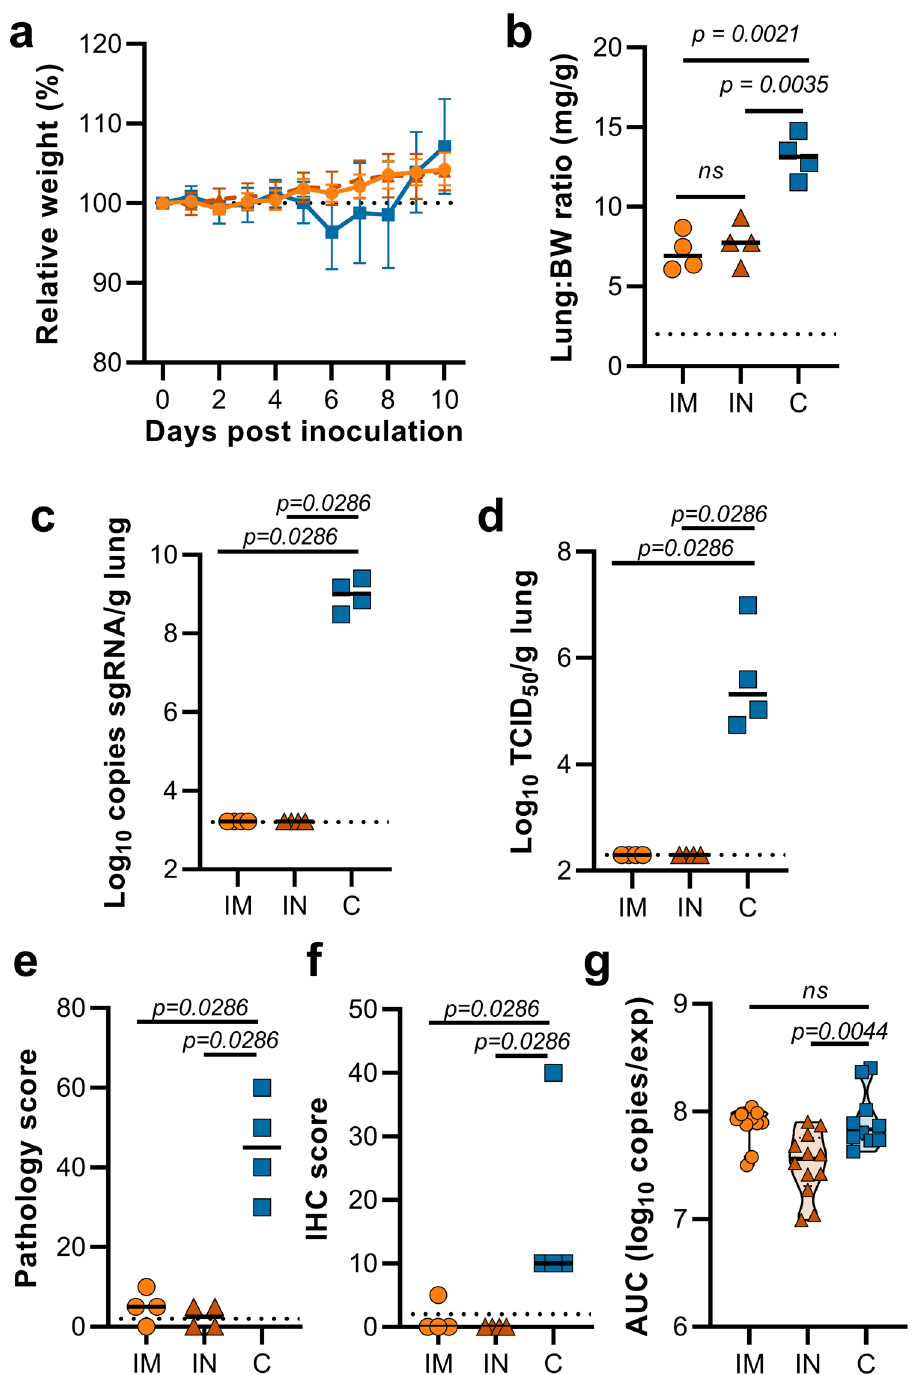
Fig. 6 Vaccination of Syrian hamsters with ChAdOx1 nCoV-19 via the IM or IN route prevents lower respiratory tract infection with SARS-CoV-2 VOC B.1.351-2. Hamsters were vaccinated by the IM or the IN routes 60 days prior to challenge with B.1.351-2. a Relative weight upon intranasal challenge with 10 4 TCID 50 of B.1.351. Shown is the geometric mean with a 95% con fi dence interval (CI). There was no statistical signi fi cance between the groups on any day. b Lung:body weight (BW) ratio (mg:g) of hamsters euthanized at 5 DPI. Line = median. c sgRNA viral load in lung tissue obtained at 5 DPI. Line = median. Dotted line = limit of detection. d Infectious SARS-CoV-2 titer in lung tissue obtained at 5 DPI. Line = median. Dotted line = limit of detection. e Percentage affected lung tissue per animal as determined via histology. Line = median. f Percentage of lung tissue positive for SARS-CoV-2 antigen per animal. Line = median. g Truncated violin plot of area under the curve (AUC) analysis of shedding as measured by sgRNA analysis in swabs collected on 1 – 5 DPI. Dashed line = median. Dotted line = quartiles. Statistical signi fi cance determined via mixed-effect analyses n = 12 biologically independent animals (vaccinated groups) and n = 10 (control group) ( a ), or two-tailed Mann – Whitney test ( b – e ) with an n of 8 biologically independent animals and ( g ) with an n of 12 biologically independent animals (vaccinated groups) and n = 10 (control group). IM = ChAdOx1 nCoV-19 vaccinated via intramuscular route; IN = ChAdOx1 nCoV-19 vaccinated via intranasal route; C = naïve animals; Orange circle = Hamsters vaccinated with ChAdOx1 nCoV-19 via intramuscular route, Orange triangle = Hamsters vaccinated with ChAdOx1 nCoV-19 via intranasal route, Blue square = Naïve hamsters.